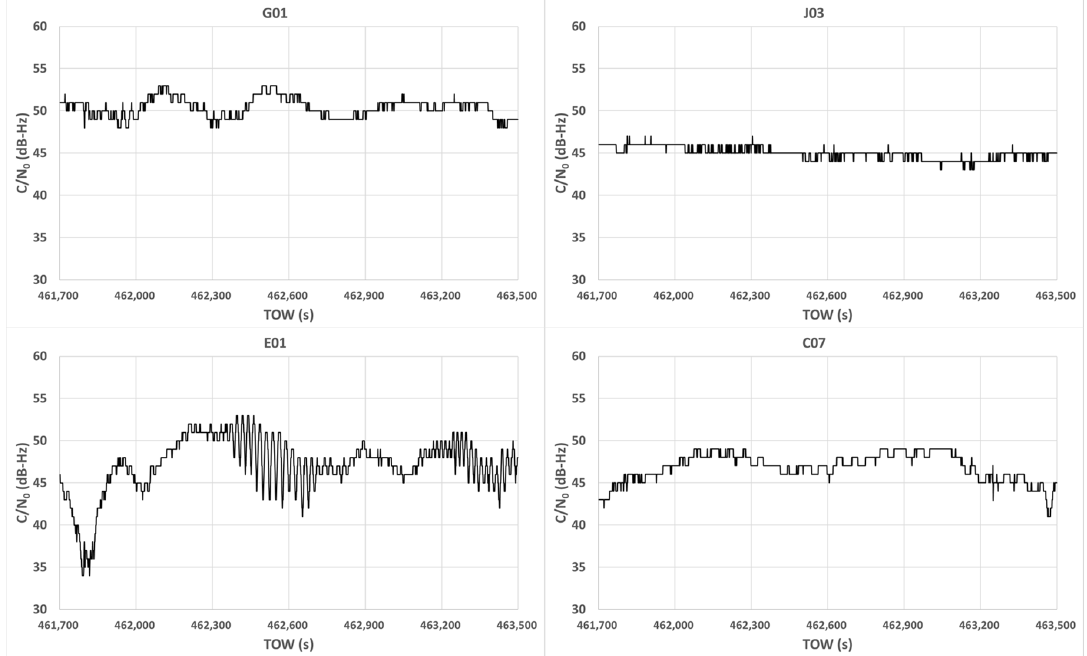
Figure 4 . Temporal C/N 0 mainly receiving line-of-sight (LOS) signals.